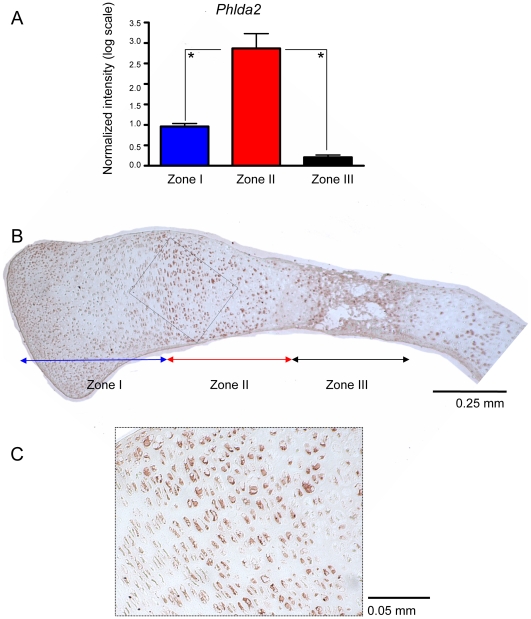
Increased expression of Phlda2 in the hypertrophic zone.(A) RNA was isolated from the 3 growth plate zones. Real-time PCR analyses showed increased expression of Phlda2 in Zone II compared to Zone I and III. The lowest levels of expression were observed in zone III (13.6 fold change compared to zone II). The presented results are relative to Gapdh endogenous control; n = 3, *p<0.05. (B) Expression pattern of Phlda2 within the growth plate after 6 days of culture in the presence of DMSO. Immunohistochemistry analysis showed increased expression of Phlda2 in prehypertrophic/hypertrophic chondrocytes (Zone II) (red-brown stain). (C) The inset shows a higher magnification of Zone II.